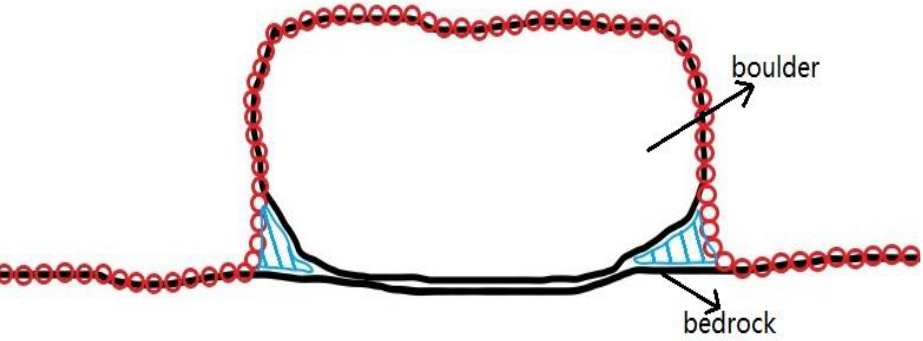
Figure 18. Errors caused by differential volume calculation based on M3C2 distance. The blue areas indicate the error area resulting from the suspension of the boulder. Red circles represent the point cloud model.